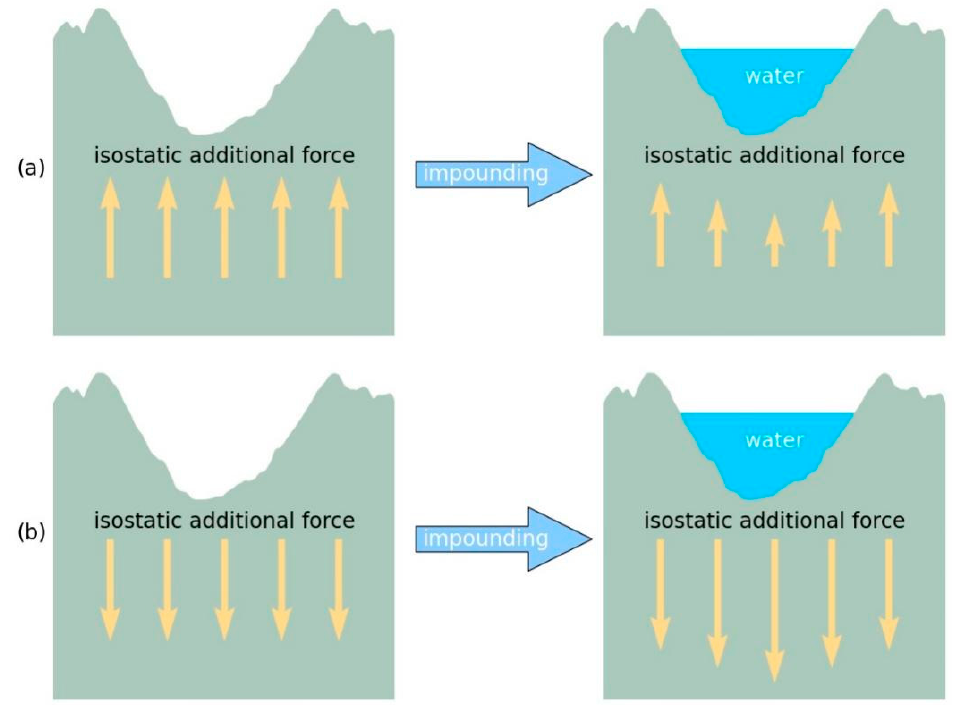
Figure 4. Sketch section of the Isostatic additional force (IAF) borne by lithosphere before and after reservoir impoundment. ( a ) Process of reservoir storage is an unloading process of force when the IAF is upward; ( b ) loading process when the IAF is downward.